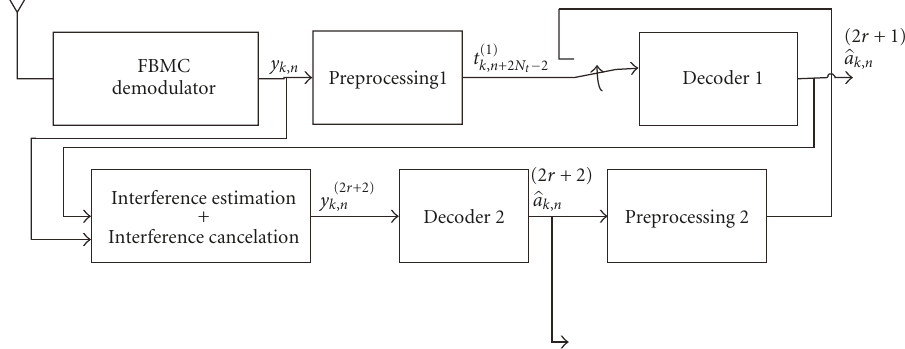
Figure 3: Receiver decoding processing for FBMC modulation in the case of single delay STTC